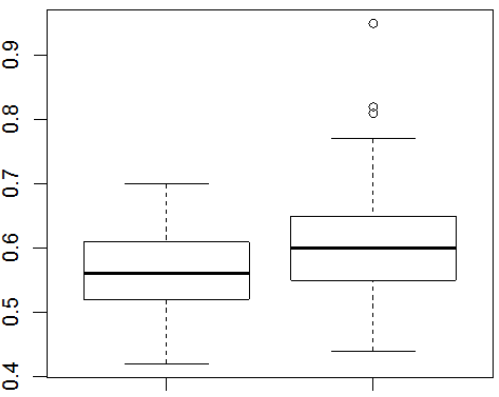
Figure 1. Mean WHtR values between the individuals without morbidities and those with 1 or more morbidities.